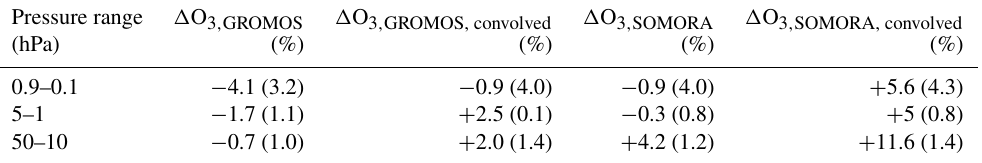
Table 5. Mean relative VMR differences ((MWR − MLS) / MWR) between MWRs and MLS at three pressure ranges, with and without AVK convolution. In parentheses we show the standard deviations of the VMR relative differences in each pressure